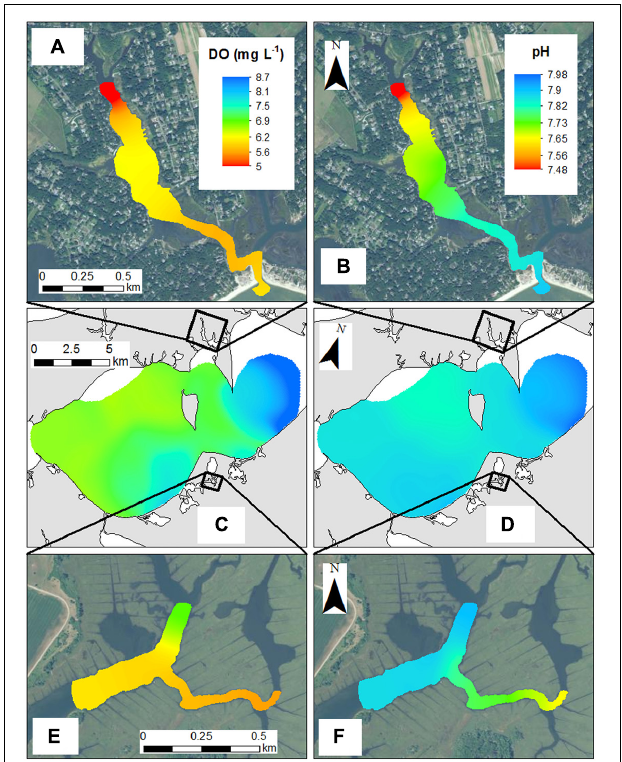
FIGURE 8 | High resolution surveys of (A) DO (mg L − 1 ) within the macroalgae (MA-1) sampling region, (B) pH within the macroalgae (MA-1) sampling region, (C) DO (mg L − 1 ) in the Peconic Estuary (OW-1), (D) pH in the Peconic Estuary (OW-1), (E) DO (mg L − 1 ) within a salt marsh habitat (SM-3), and (F) pH within a salt marsh habitat (SM-3). All cruises were conducted in